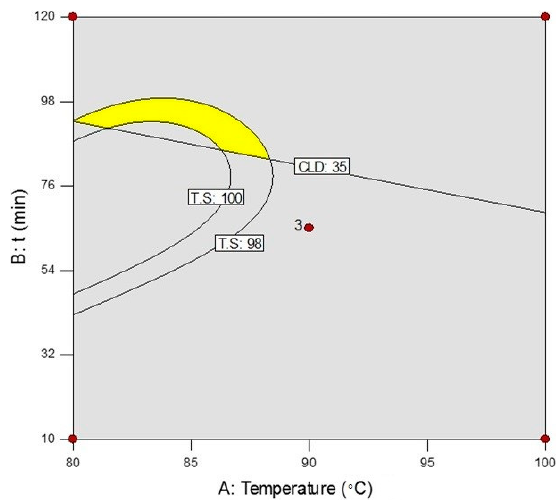
Figure 3. The overlay plot of cross-linking degree (CLD) and Tensile strength (TS). The yellow region is the intersection area of the criteria limits where the optimal conditions were designated. The red point in the middle of this picture shows the condition of the central point i.e., 90 °C, 60 min.